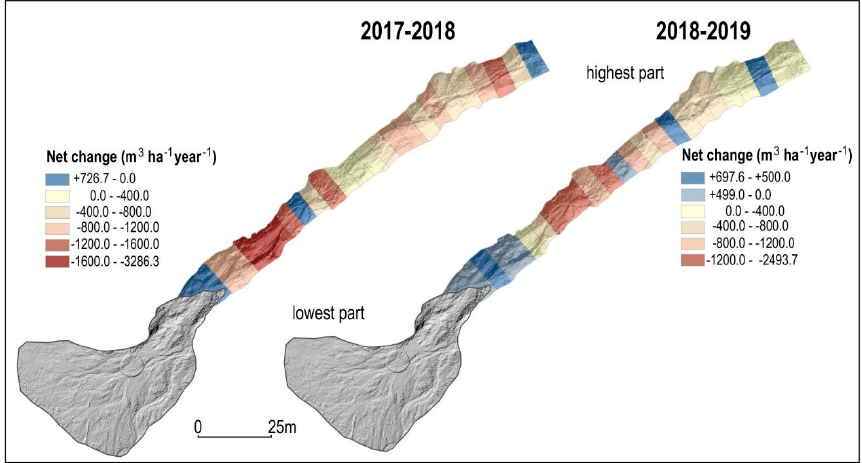
Figure 7. Net change on selected test surfaces within forest road between 2017–2018 and 2018–2019.